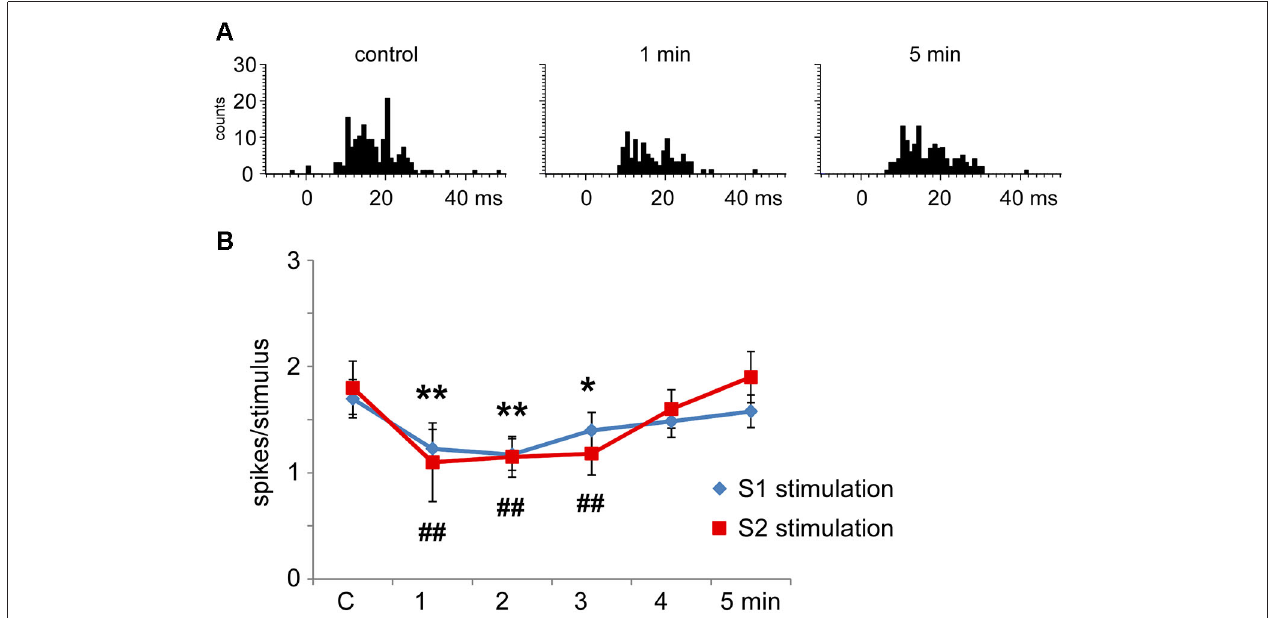
stimuli; 50 Hz during 500 ms repeated every 2 s) in Pr5 neurons recorded in an unmatched condition ( n = 35 and n = 9, respectively). Cortical stimulation inhibited tactile responses for 3 min. In this and in the following figures * P < 0.05, ** P < 0.01 statistical significance after S1 stimulation train with respect to control values; # P < 0.05, ## P < 0.01 after S2 stimulation train.